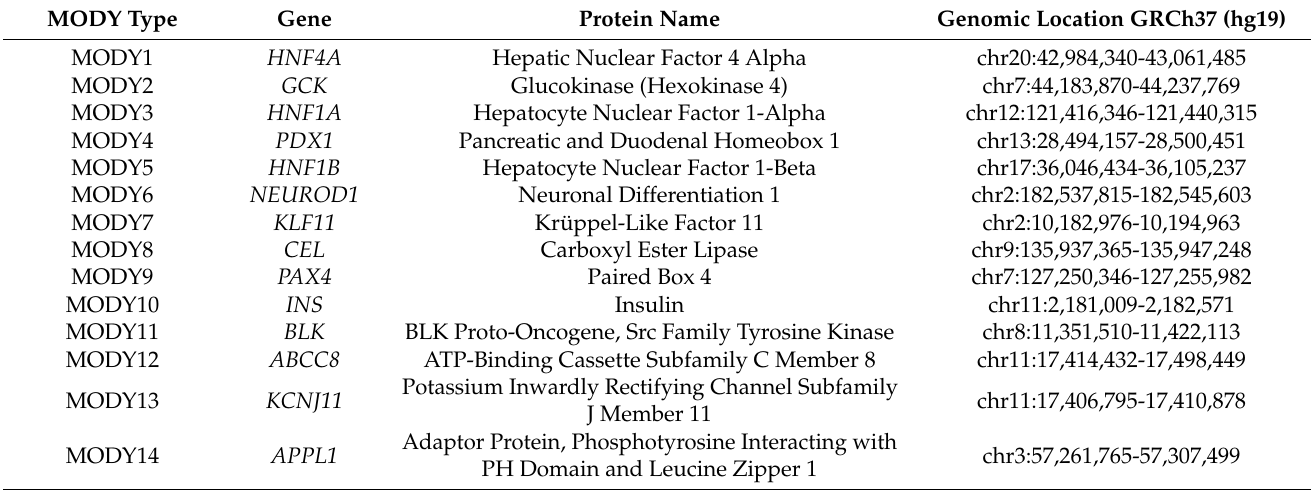
Table 1. The genes associated with maturity onset diabetes of the young